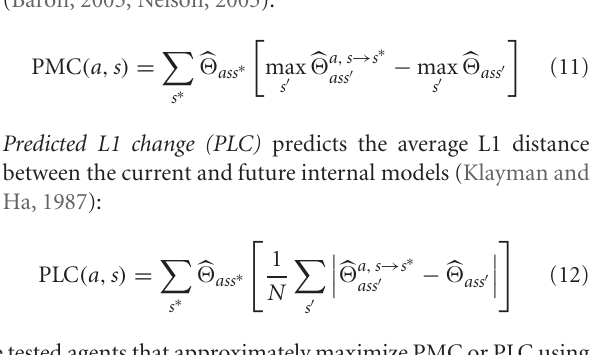
Frontiers in Neural